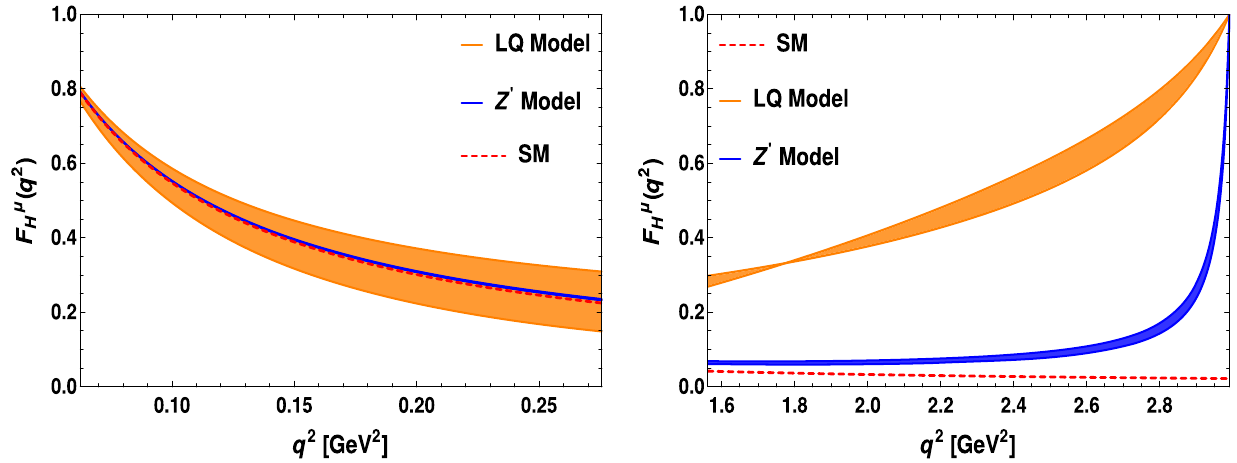
Fig. 5 The variation of the flat term of D + → π + μ + μ − with respect to low q 2 ( left panel ) and high q 2 ( right panel ) in the scalar leptoquark and Z (cid:2)